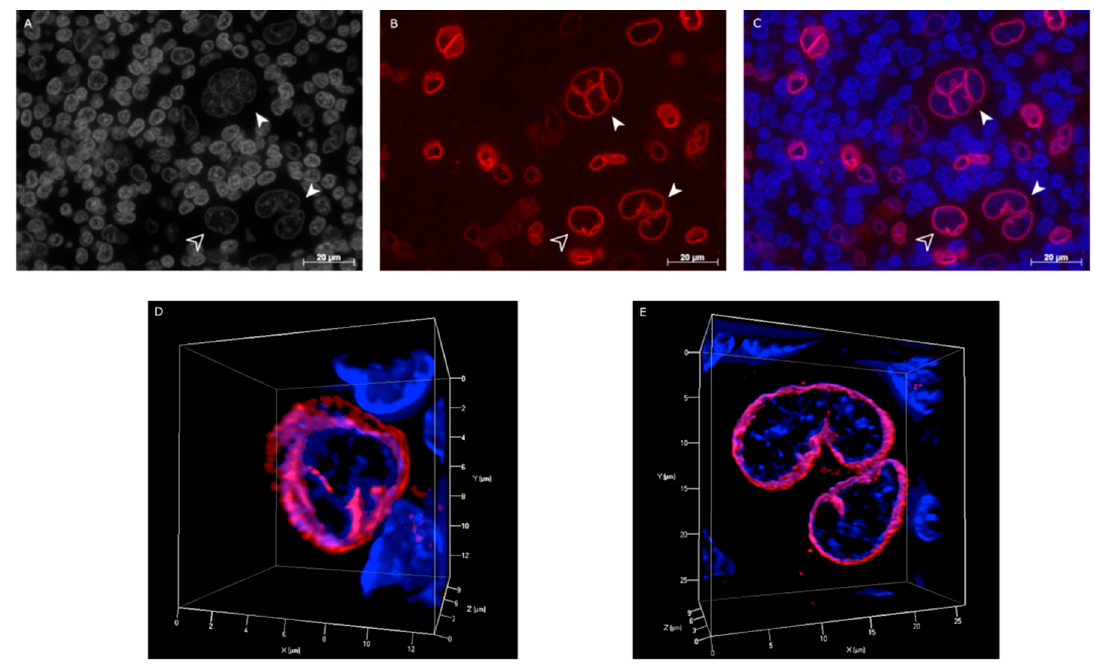
Figure 4. Example of lamin A/C expression in primary Hodgkin’s lymphoma paraffin-embedded pre-treatment lymph node tissues from patients diagnosed with cHL. ( A ) 2D image of nuclei stained with DAPI (gray scale); ( B ) 2D image of anti-lamin A/C antibody immunostaining (red); ( C ) 2D merged image showing H (empty arrowhead) and RS (solid arrowhead) cells positively stained for lamin A/C. 3D reconstruction of patient-derived mono-nuclear Hodgkin (H) ( D ), and bi-nuclear (RS) cells ( E ), presenting the same patterns of irregular lamin A/C 3D structure characterized by internal lamin structures and points of protein accumulation, similar to those seen in the HL derived cell lines.